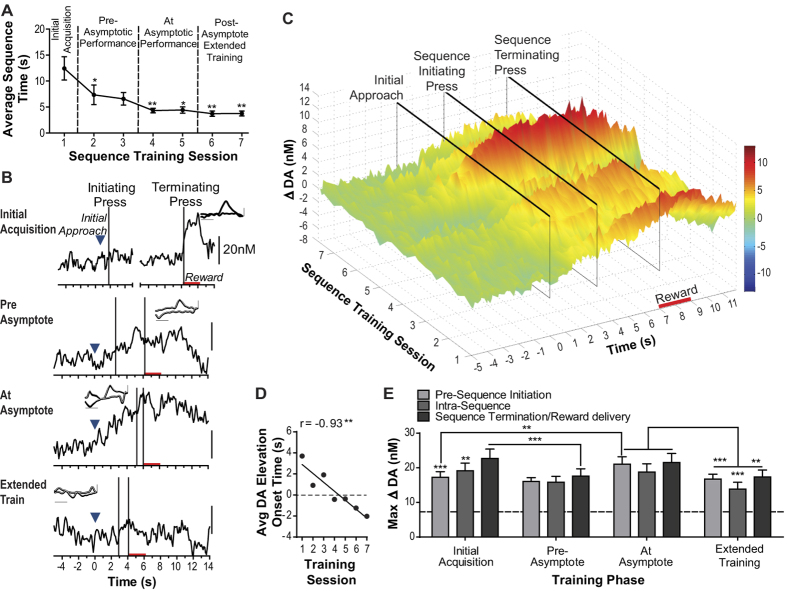
Dopamine concentration changes during action sequence learning and performance.(A) Average sequence completion time (initial lever press-reward collection) across training. (B) Single-trial representative dopamine concentration v. time traces from the same rat for each phase of training. All except the top trace where the break is indicated, show continuous, unaveraged, non-concatenated traces. Blue arrows: time of initial approach towards the initiating lever. Insertion of the terminating lever occurs immediately following the initiating lever press. Red bars: reward delivery and consumption (rats collected earned reward on average 0.27 s, SEM = 0.02, following the terminating lever press). Insets: Background-subtracted cyclic voltammograms (CVs) showing oxidation and reduction peaks that identify the detected electrochemical signal as dopamine. Initial acquisition CV from the peak of current following reward delivery. All other CVs are average of CVs taken at 1-s intervals for the duration of the concentration ramp starting 1 s (pre-asymptote) or 6 s (at asymptote and extended train) prior to the initiating press and extending 9 s after this press. Shading reflects +1 within-sample SEM. X-axis scale bar: 0.5 V and the y-axis scale bar: 0.5 nA. (C) Concatenated, baseline-subtracted dopamine concentration v. time traces (see Methods) were averaged across bins of 10 sequence completions (3 bins/training session), for each rat and then averaged across rats. Dopamine concentration change coded in false color. (D) Average dopamine concentration elevation onset time v. training session number within-subject correlation. (E) Trial-averaged peak dopamine concentration change during sequence execution (preceding the initiating press, after the initial press but prior to the terminating press, or following sequence termination when the reward was delivered and consumed). Dashed line: baseline root mean square (RMS) noise in the dopamine concentration trace in the absence of lever pressing activity. Error bars indicate +1 SEM. *p < 0.05, **p < 0.01, ***p < 0.001. See also Supplementary Figures 1–4 and Supplementary Table 1.